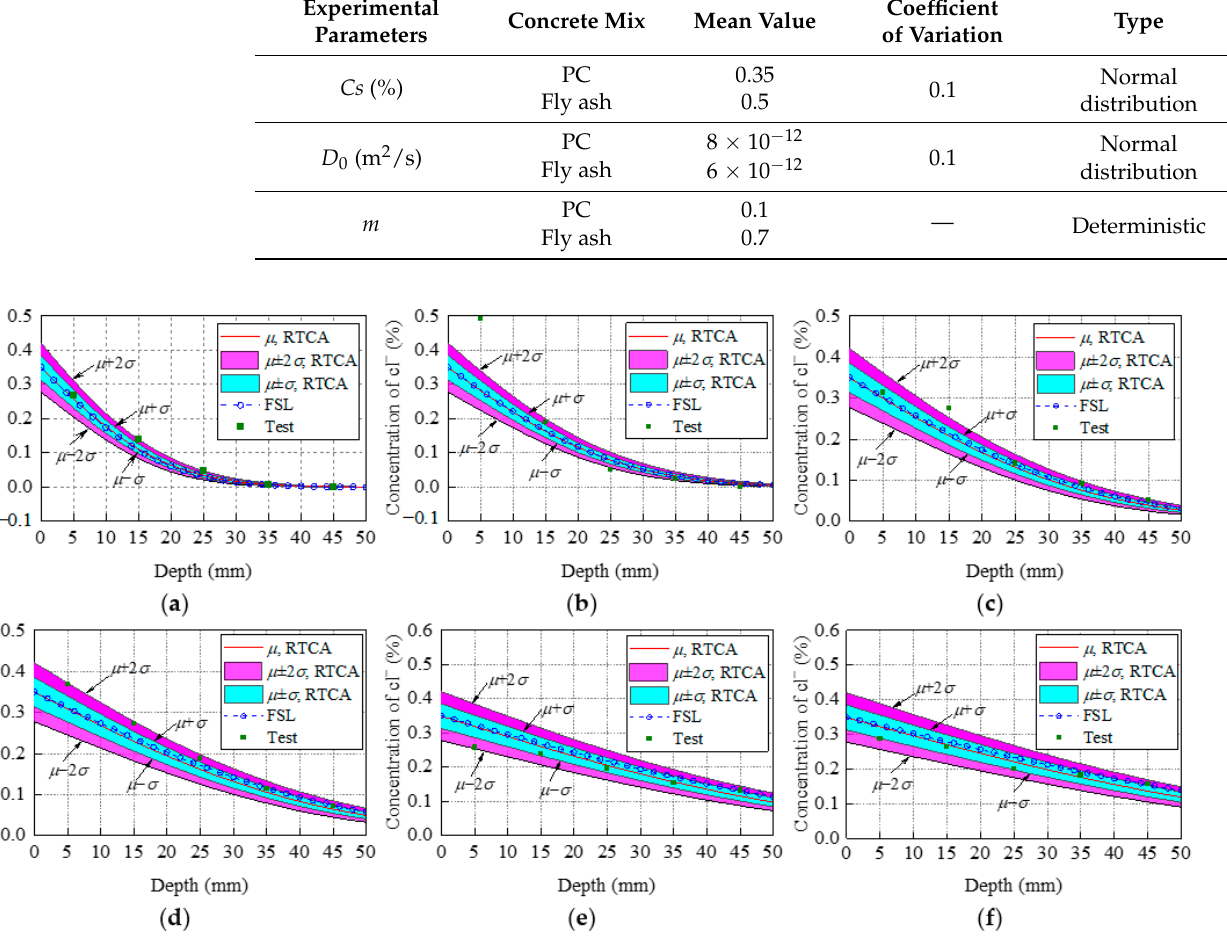
Figure 8. Comparisons between the statistical result ( μ σ ) using the 3D RTCA model, FSL analytical solution, and test data for PC concrete: ( a ) t = 0.5 year; ( b ) t = 1 year; ( c ) t = 2 years; ( d ) t = 3 years; ( e ) t = 6 years; ( f ) t = 8 years.